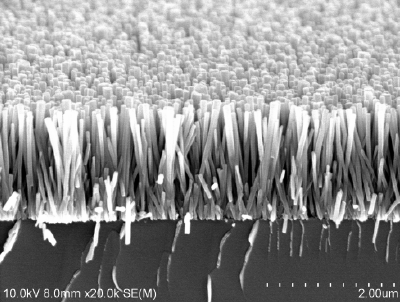
Figure 1. The cross-sectional SEM image of the as-grown nanorods. Figure 2a. The theoretical diffraction angle of ZnO (002) is at 34.422 degrees according to